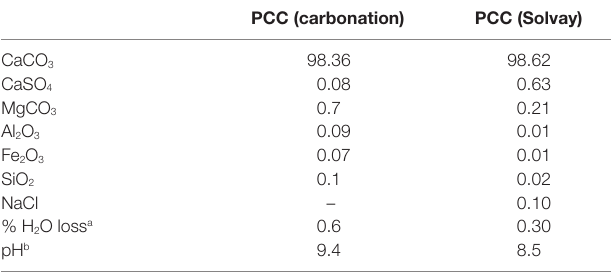
TaBle 1 | chemical composition of Pcc products by process (unit: %, statton, 2012).